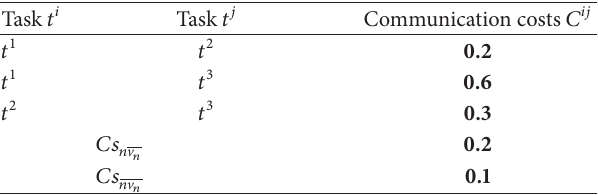
Table 6: High slowdown. Communication